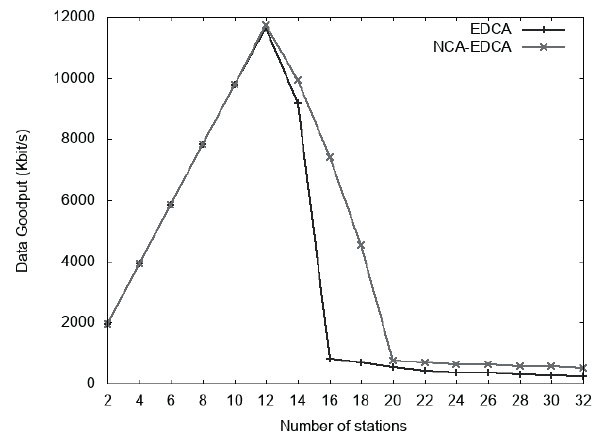
Fig. 8. EDCA and NCA-EDCA data